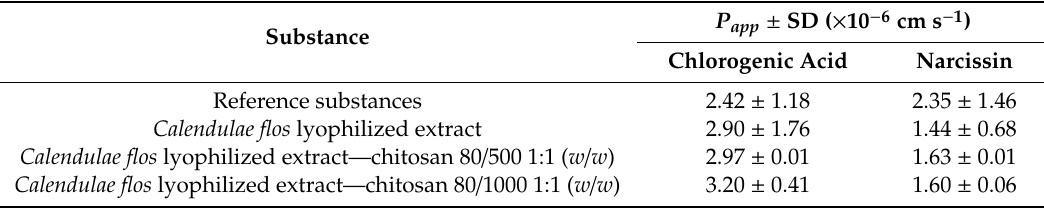
Table 3. Apparent permeability values of the chlorogenic acid and the narcissin from Calendulae flos lyophilized extract and its chitosan delivery systems.